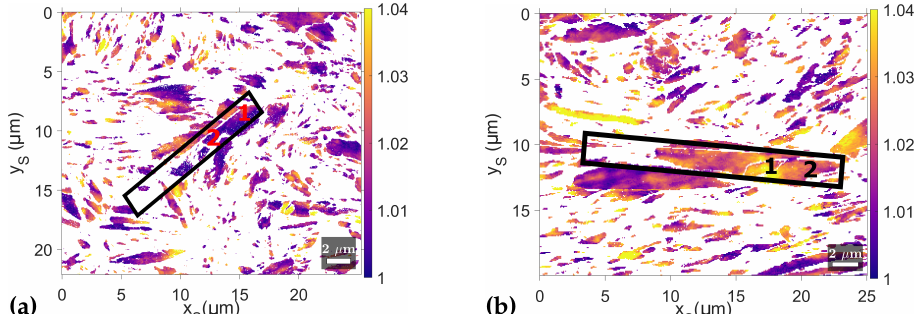
Figure A1. Local tetragonality map c / a determined by projective Kikuchi pattern matching [13,16] in EBSD with normalised cross-correlation coefficient r above 0.4. The white regions contain data points with a r value below 0.4 or are retained austenite. Lift-out regions ( a ) B and ( b ) C are marked by a black rectangle and the numbers 1 and 2 indicate the approximate positions of the APT tips, e.g., B1 or C2.